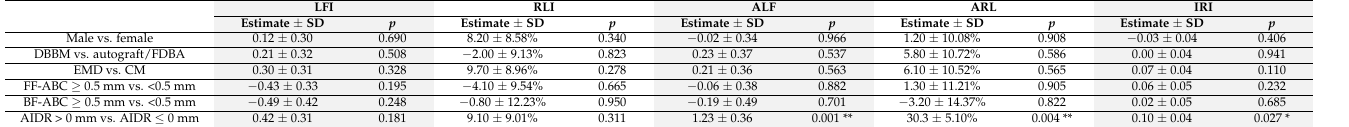
Figure 3. The representative combined furcation-angular defect cases at initial (pre-operative phase) and 6 months following the regenerative procedure. ( A ) FDBA with CM ( B ) DBBM with CM. ( C ) FDBA with EMD. ( D ) DBBM with EMD. Abbreviations: FDBA: freeze-dried bone matrix; CM: collagen membrane; DBBM: deproteinized bovine bone matrix; EMD: enamel matrix derivatives. Table 5. Generalized linear model for the effects of the demographic characteristics, treatment strategies, furcation–ABC relationship, and AIDR on the outcome of FDR in the combined furcation– angular defect group. The data was adjusted by age.